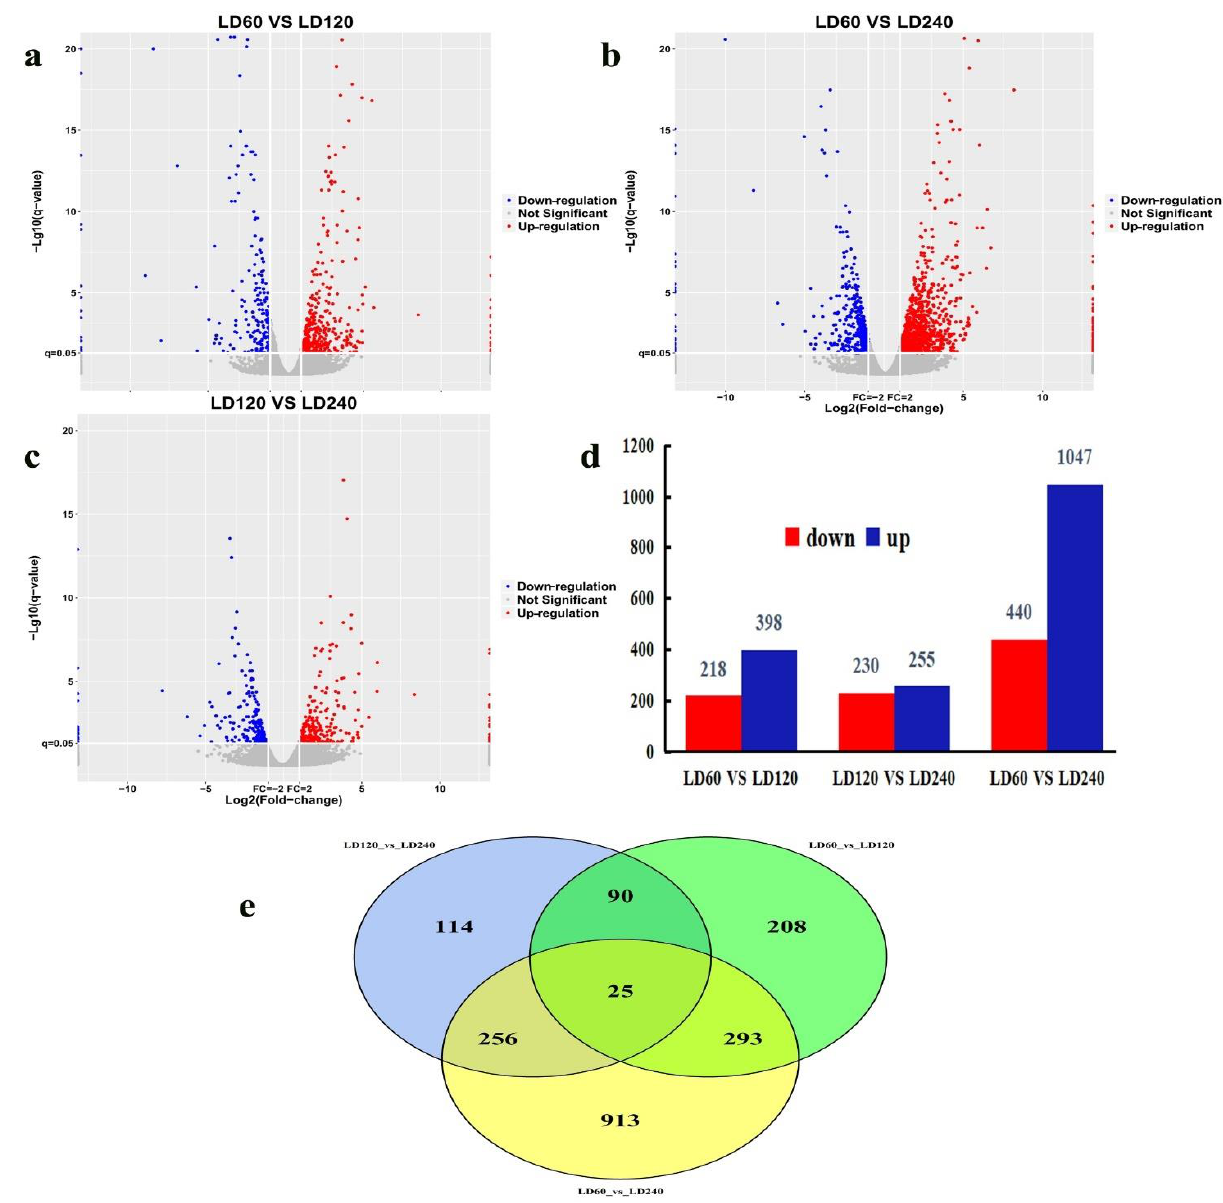
Figure 3. Volcano map and number of DEGs in different comparison groups at different develop- mental stages of WH pig. ( a – c ) Volcanic maps of DEGs in different comparison groups at different developmental stages. ( d ) Numbers of DEGs at different stages of WH pig. ( e ) Venn diagram of DEGs at different developmental stages of WH pig.